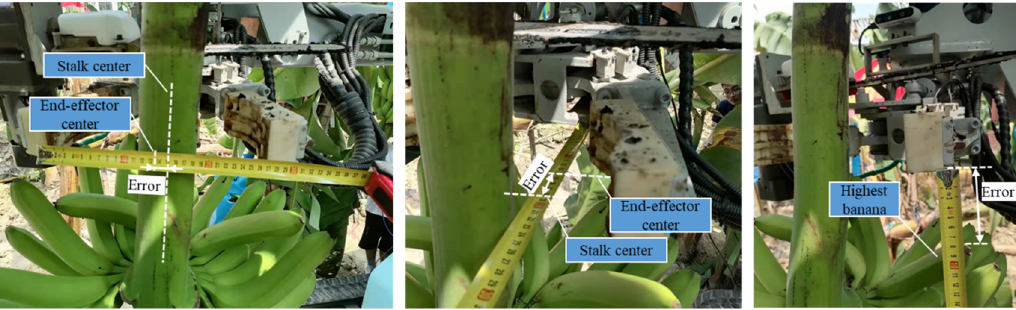
Figure 7. Example showing how to measure the errors of the end ‐ effector relative to the stalk center in the end ‐ effector width ( left ), depth ( middle ) and height ( right ) directions. Notably, because the actual height of a detected stalk is unknown, the height error is determined by measuring the vertical distance between the end ‐ effector and the top fruit.